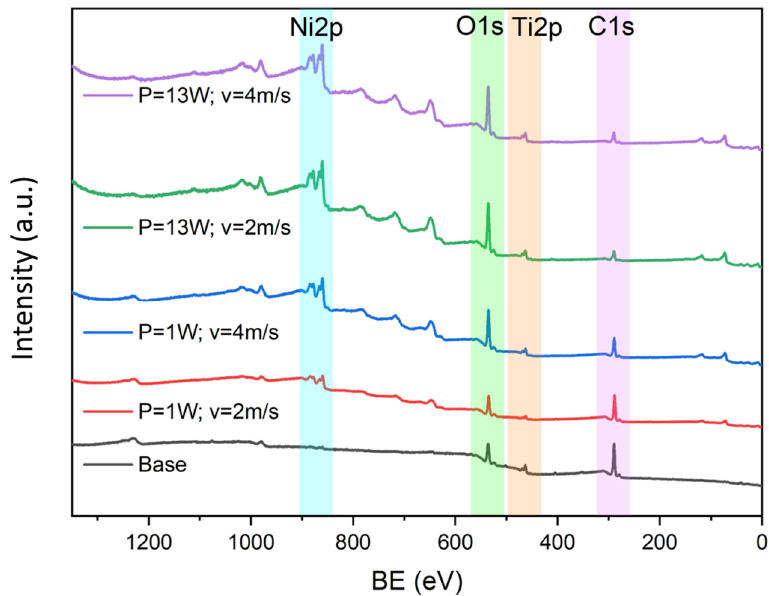
Figure 8. Overview of XPS spectra of the laser textured surfaces and the initial surface (as it is).